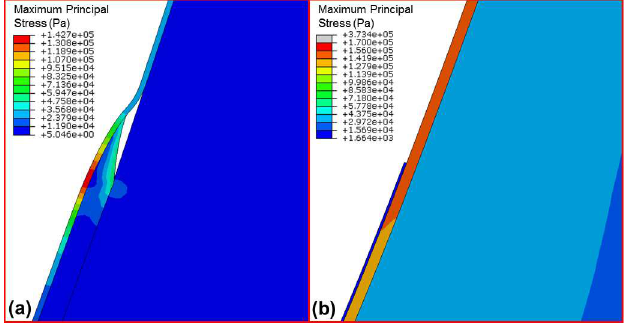
Fig 7. Maximum principalstress under maximum intrauterinepressure conditions for (a) a model with a section of the chorionremovedand (b) a model with a section of amnion removed.